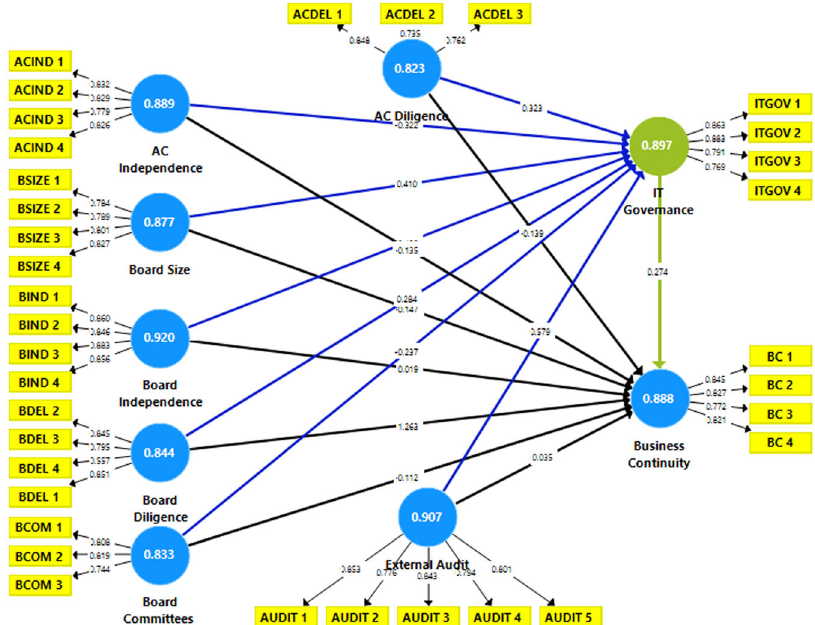
Fig. 3 Con fi rmatory factor analysis. This fi gure provides the constructs ’ con fi rmatory factor analysis (CFA). The CFA has been estimated based on the conceptual framework presented in Fig. 1 . It delivers the values of the factor loading, validity, and reliability of